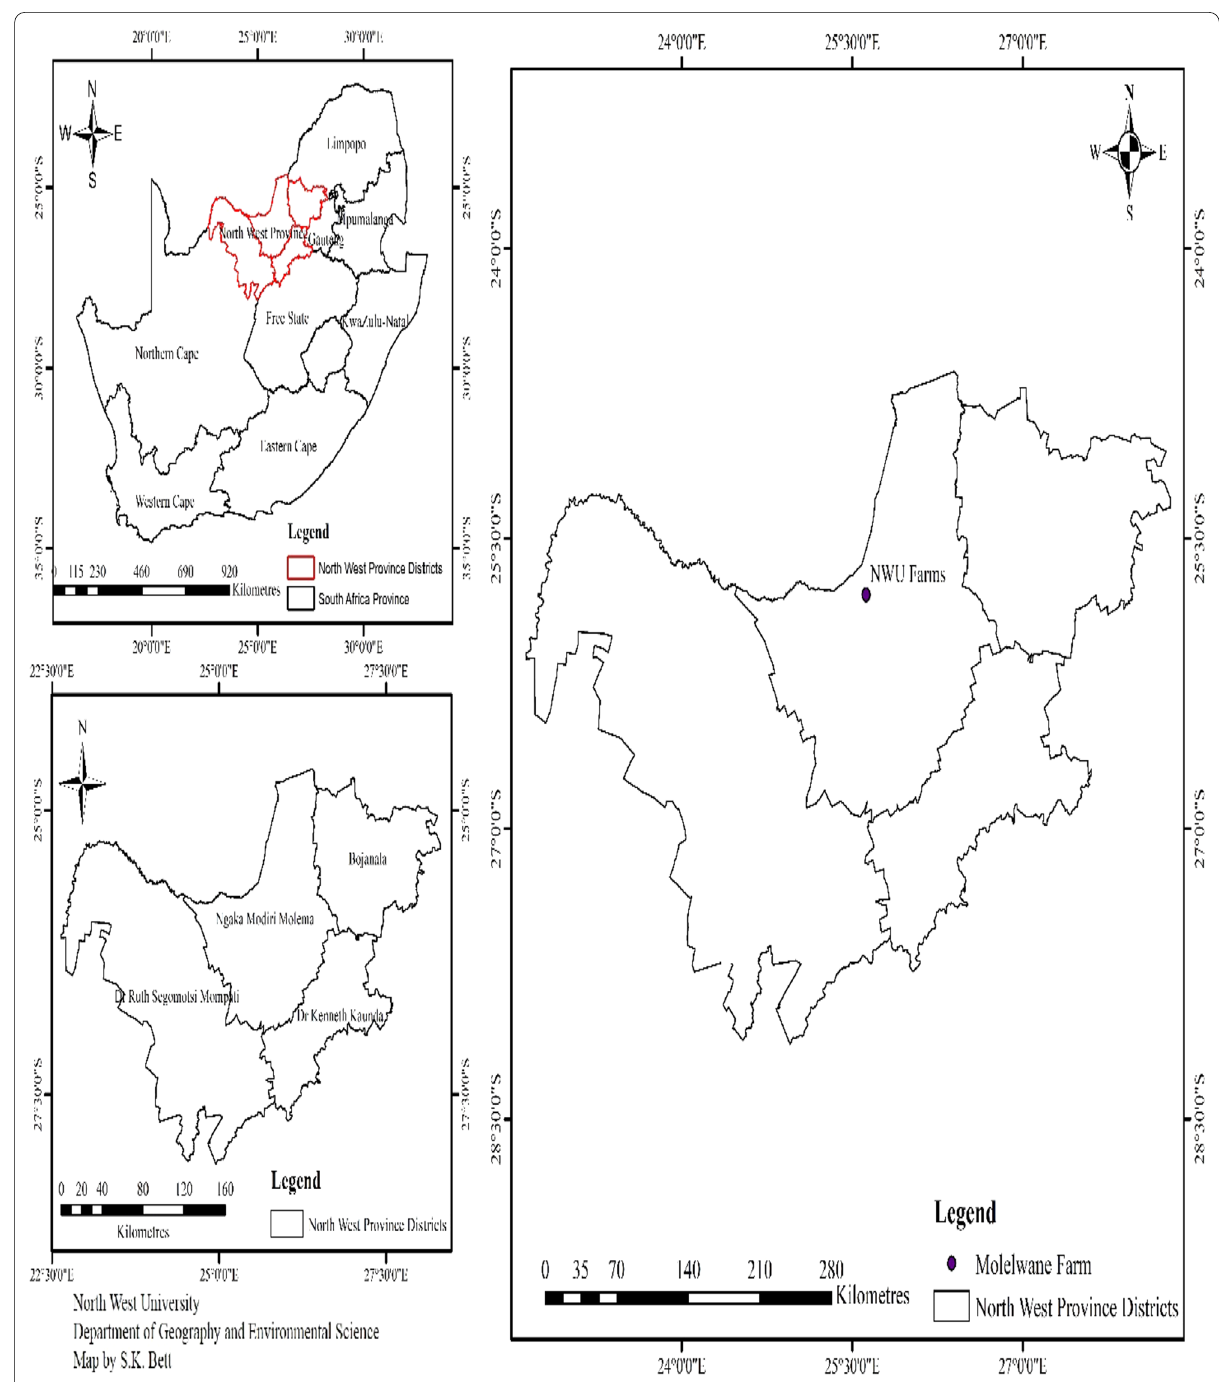
Fig. 1 The map of the agricultural sampling site at the Molelwane, North-West University farm, Mafikeng, South